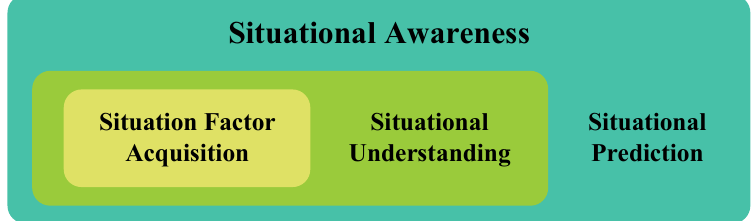
Figure 2. Endsley situational awareness